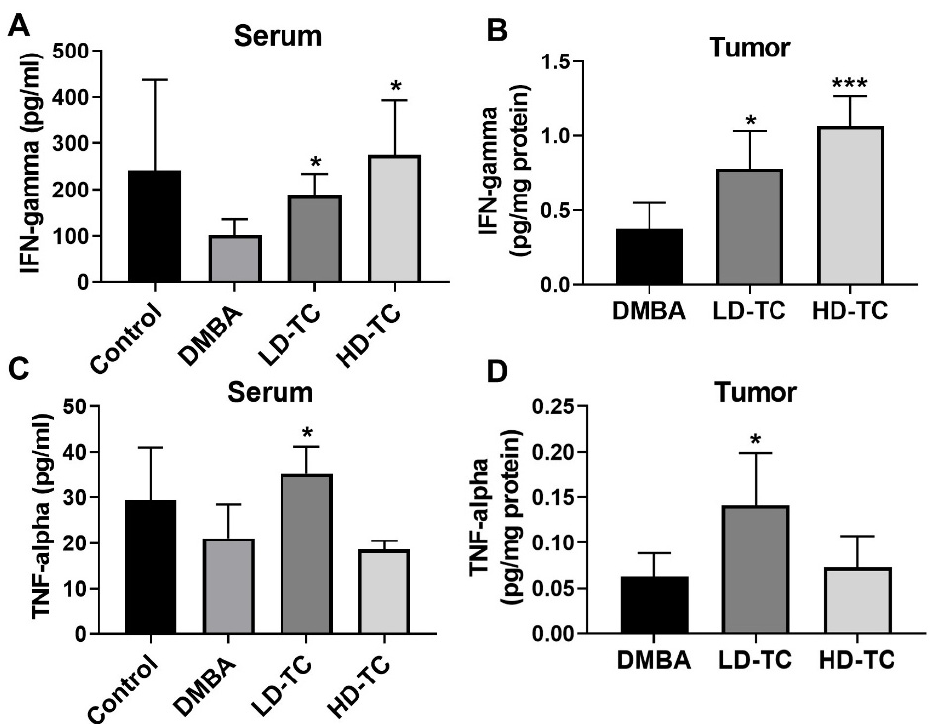
Figure 6. Effects of theacrine on the IFN- γ and TNF- α levels in serum and tumor tissue of DMBA- treated rats. Levels of IFN- γ in serum ( A ) and tumor tissue ( B ) as well as TNF- α in serum ( C ) and tumor tissue ( D ) were quantitated by ELISA. The results were shown as mean ± SD ( n = 5 for serum sample and n = 6 for tumor tissue). Values were found statistically significant at p < 0.05; * p < 0.05, *** p < 0.001 as compared with the DMBA group.